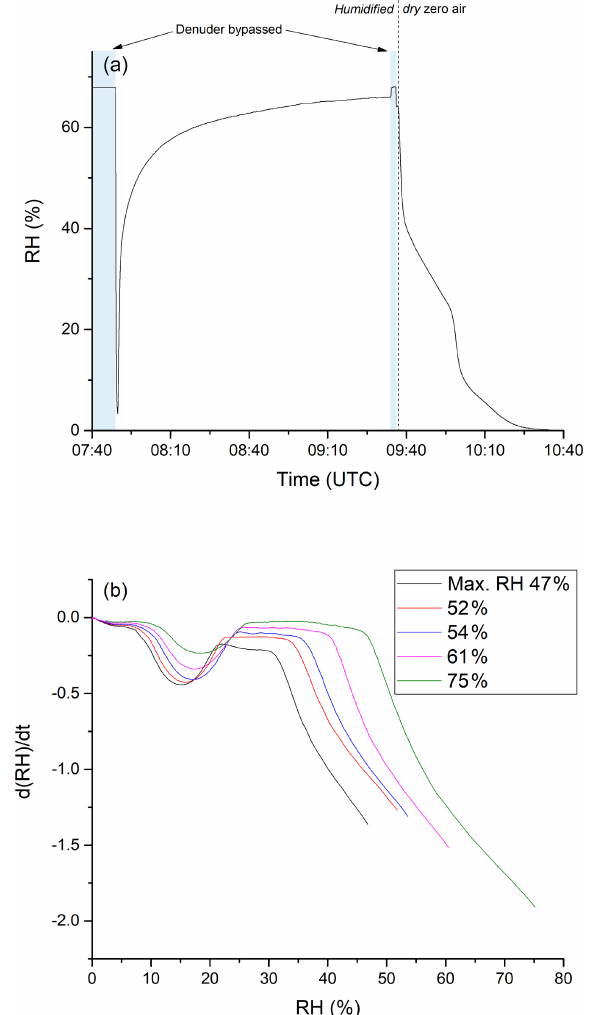
Figure 8. (a) RH of humidified zero air after passing through the denuder. The initial RH was determined by bypassing the denuder before and after the experiment. Zero air was humidified by flowing a fraction of the stream through deionised water stored in a glass vessel. The time at which the experiment was conducted is given on the x axis. Until ca. 09:35UTC, zero air with constant humidity (RH ca. 68%) was sent through the denuder. Afterwards the denuder was exposed to dry zero air. (b) Derivative of the measured RH during the drying period. The step during the drying phase occurs in a higher RH area when starting the drying from a larger RH value.